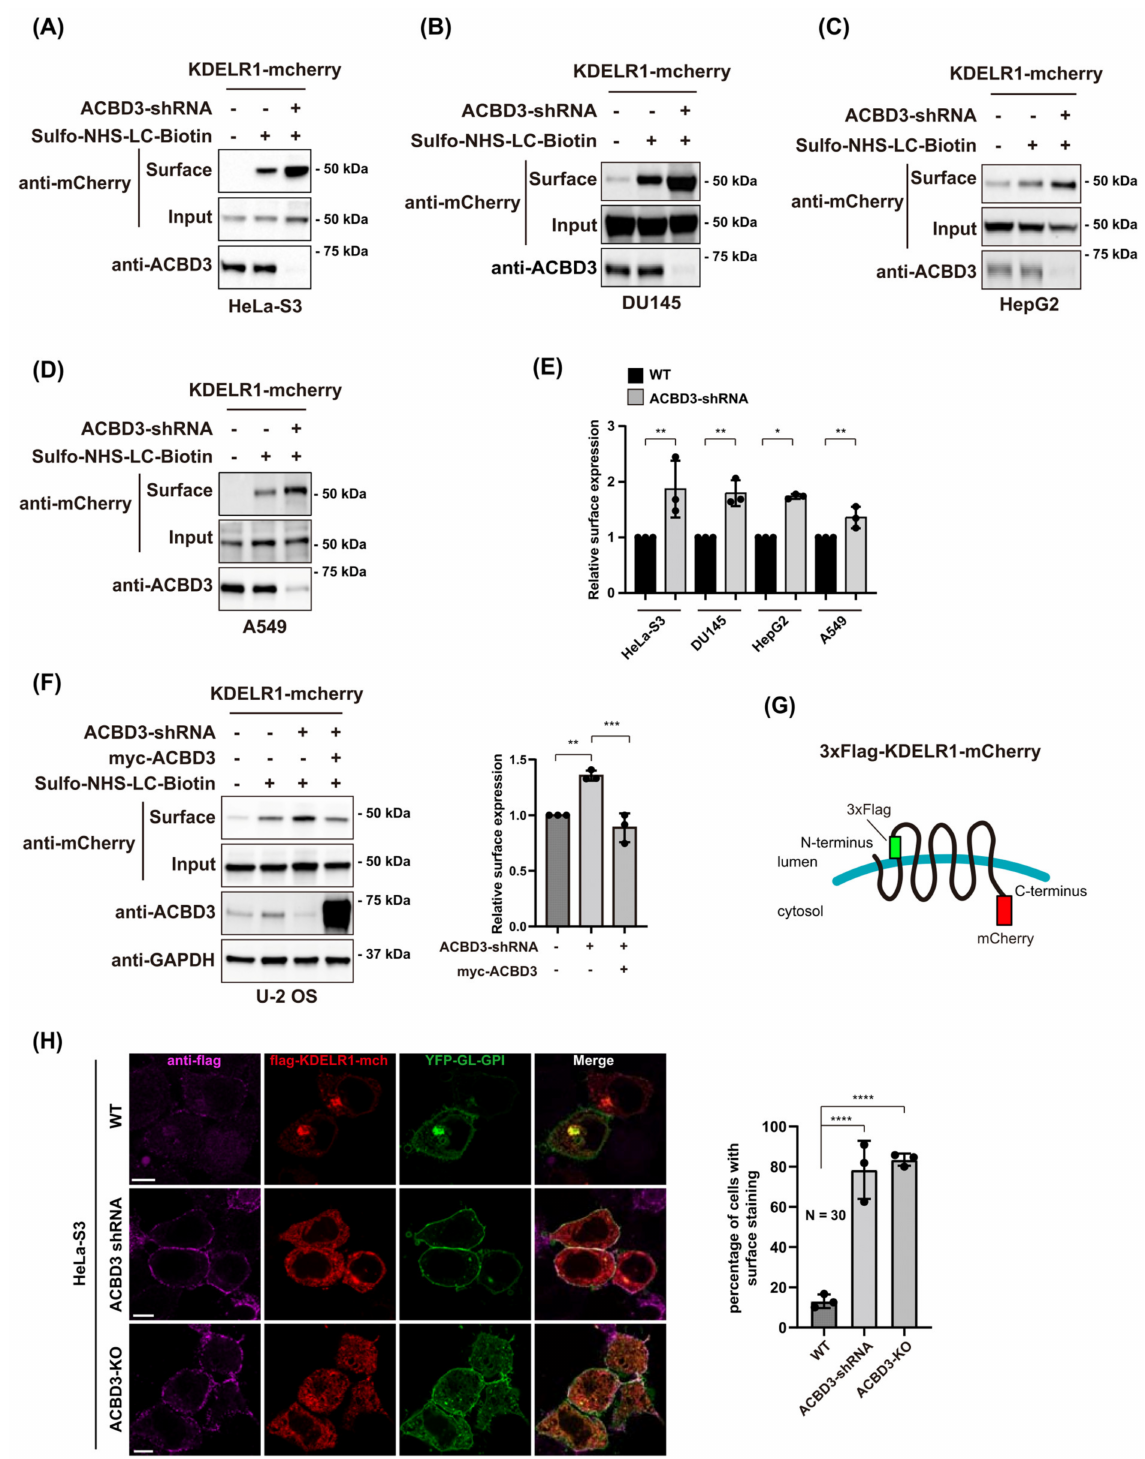
Figure 2. ACBD3 depletion causes significantly increased expression of KDEL-R1 on the cell surface. ( A – D ) Cell surface expression of KDEL-R1-mCherry is significantly increased in a number of ACBD3 depleted cell lines, compared to the control cells. Cell surface expression of KDEL-R1-mCherry was probed via cell surface biotinylation protocol using sulfo-NHS-LC-biotin. We used a shRNA/lentiviral transduction method to establish four mammalian cell lines, for which ACBD3 was stably knocked down, as described in the Methods. Briefly, WT or ACBD3 depleted cells were transfected with KDEL-R1-mCherry for 18 h, followed by cell surface biotinylation. Biotinylated proteins were